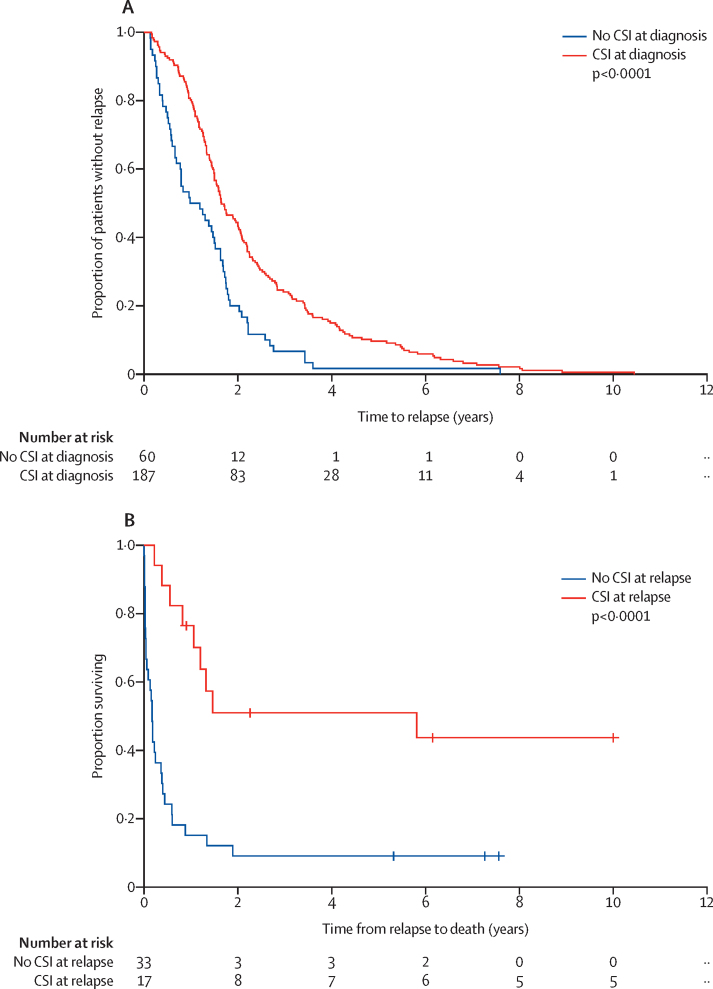
Time to relapse and survival after medulloblastoma relapse according to treatment received(A) Time to relapse according to whether CSI was delivered at diagnosis. (B) Time from relapse to death or last follow-up in patients who did not receive upfront CSI, according to whether CSI was delivered at relapse. Ten patients were removed from time from relapse to death analysis due to: death from other cause (n=1), alive with disease (n=5), or missing data (n=4). CSI=craniospinal irradiation.